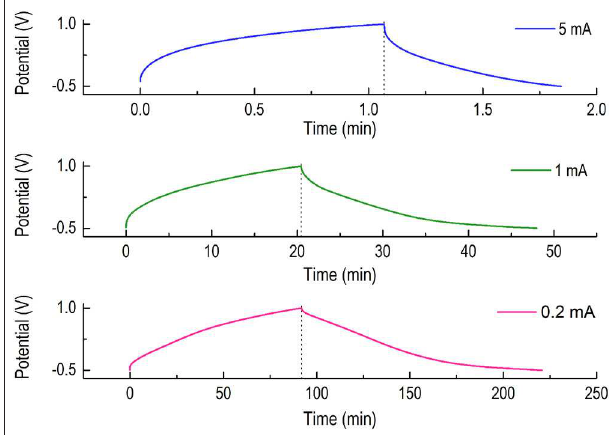
FIGURE 6 | Charge discharge analyses (CC/CC mode) were performed for NDRGO-Mo-Li-2S using a constant charging and discharging current of 5, 1, and 0.2mA in the voltage range of − 0.5V to + 1.0V.